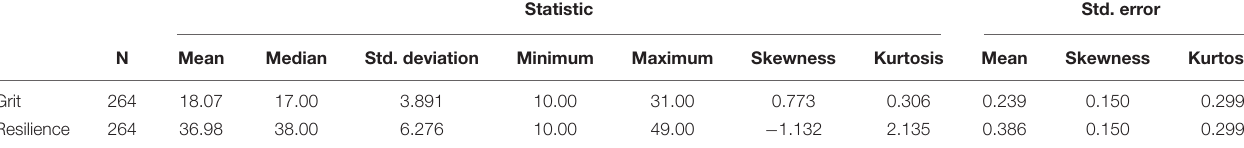
TABLE 2 | Statistics of the participants about resilience, grit, and creativity. Statistic Std. error